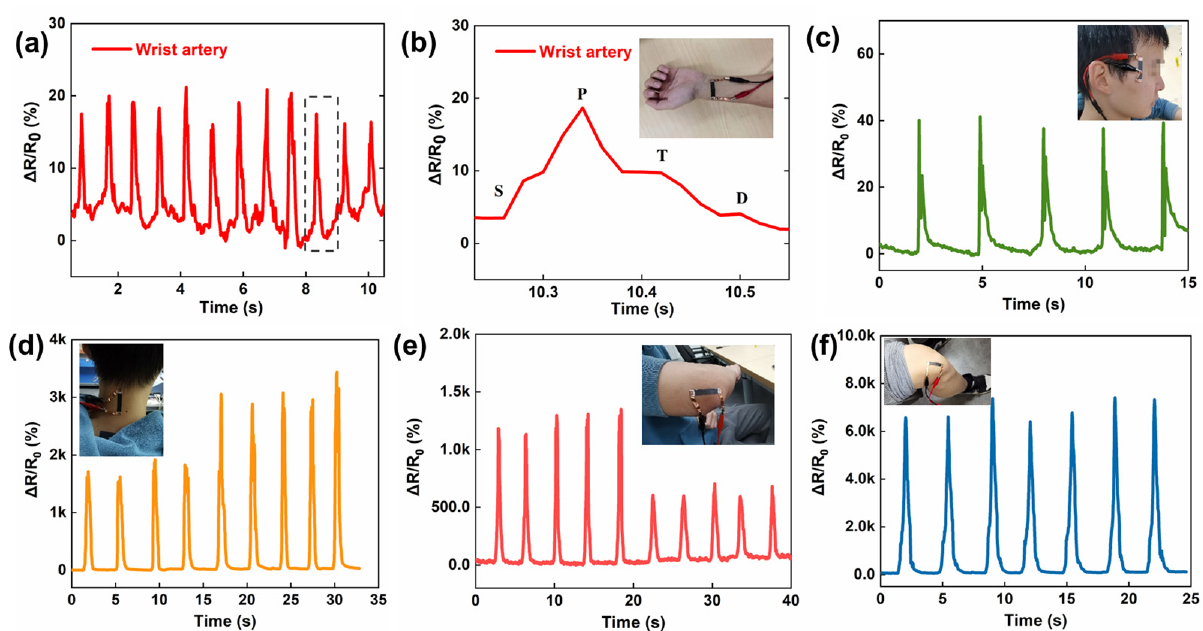
Figure 4. Mechanical physiological signals detected by SCG e-skin. ( a ) Pulse signals detected by the SCG e-skin on the wrist artery. ( b ) The zoomed-in graph of a single pulse signal. Inset: tester with the SCG e-skin attached to the wrist. ( c ) Blinking detected by the SCG e-skin attached next to the eye. Inset: tester with the SCG e-skin attached next to the eye. ( d ) Small and large range of neck movement detected by the SCG e-skin. Inset: tester with the SCG e-skin attached to the neck. ( e ) Small and large range of bending movement of elbow detected by the SCG e-skin. Inset: tester with the SCG e-skin attached to the elbow. ( f ) Bending movement of the knee joint detected by SCG e-skin. Inset: tester with the SCG e-skin attached to the knee.